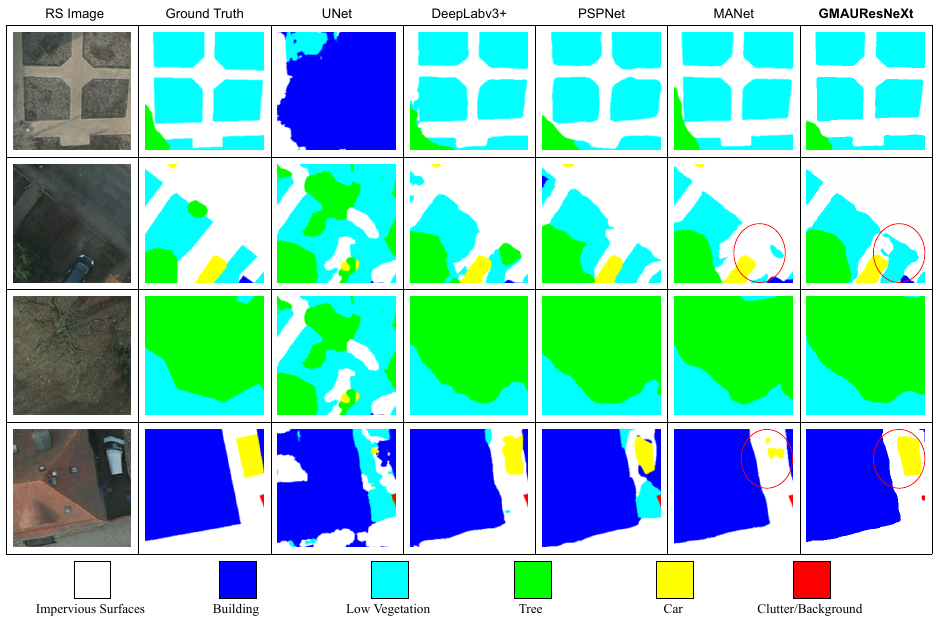
Figure 5. Qualitative comparisons of the segmentation results for the Potsdam dataset generated by different semantic segmentation